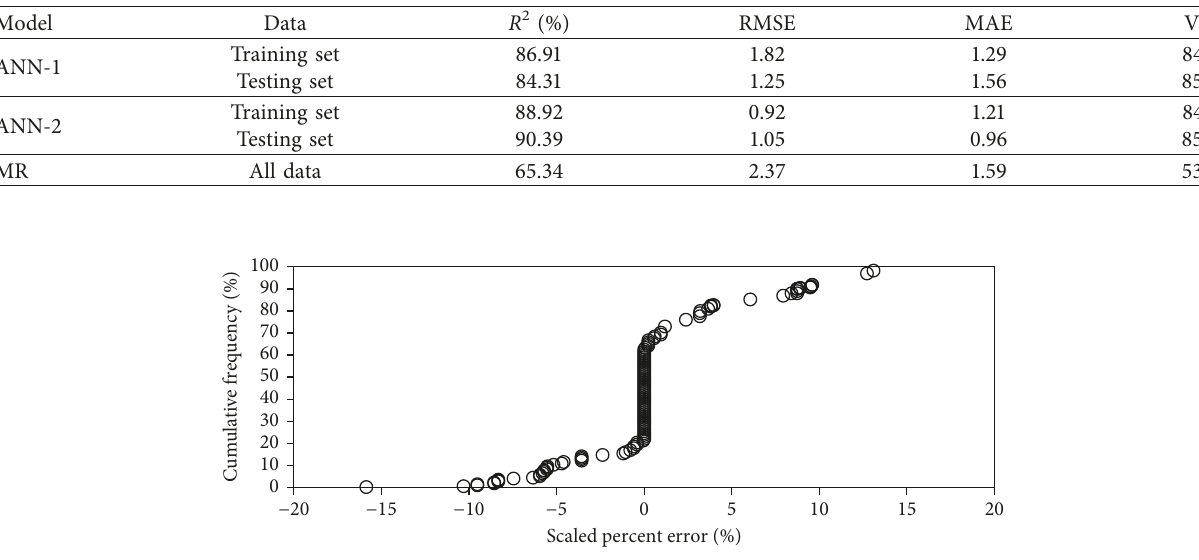
Figure 7: Scaled percent error of the BPN predicted from the ANN-1 model.